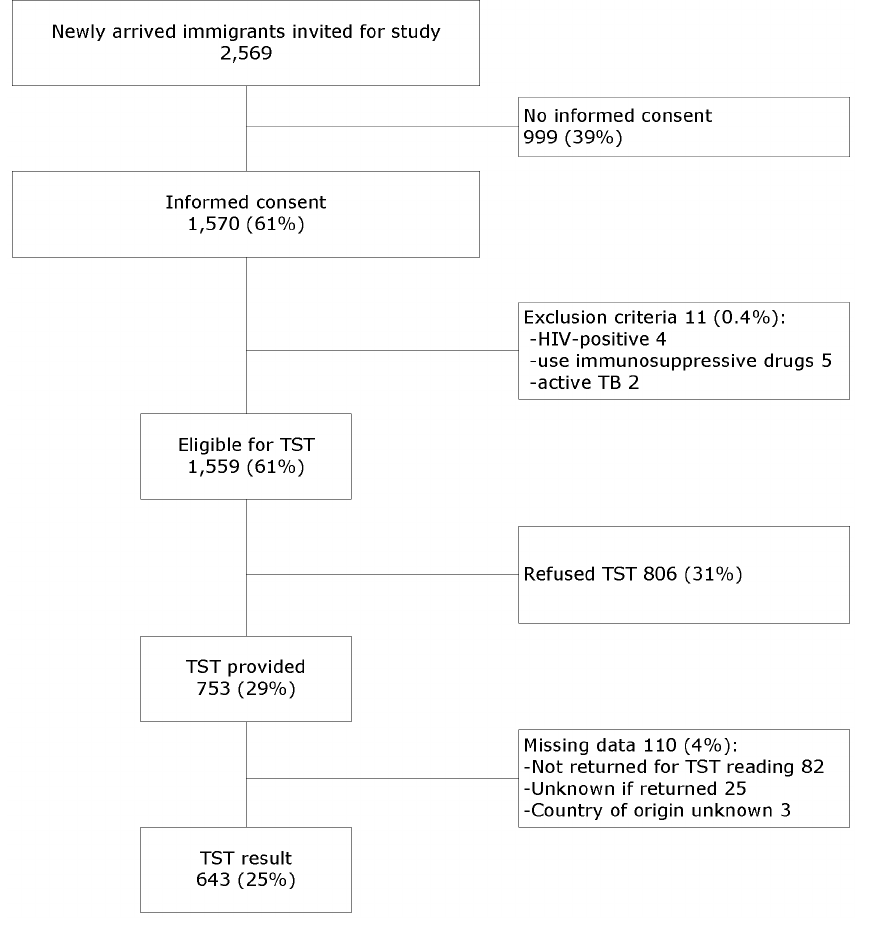
Figure 2. Flow diagram of study participants.